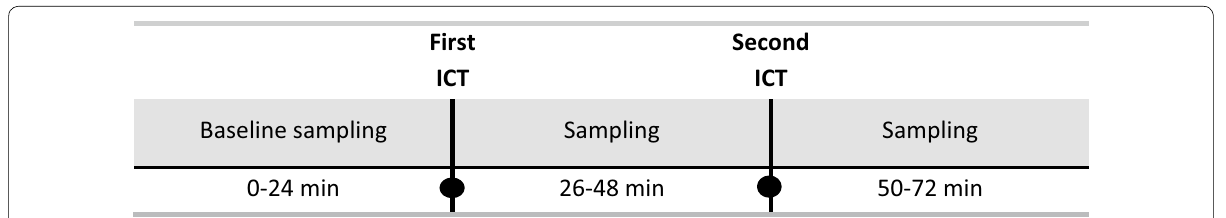
Fig. 1 Microdialysis flow chart. The first ICT after 24 min was performed with penicillin, grass, NaCl or codeine. The second ICT after 48 min was always performed with